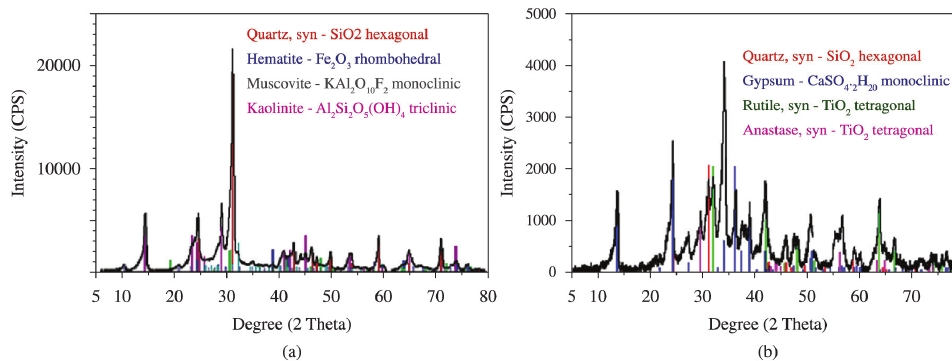
Figure 2. XRD of (a) kaolinitic clay and (b)